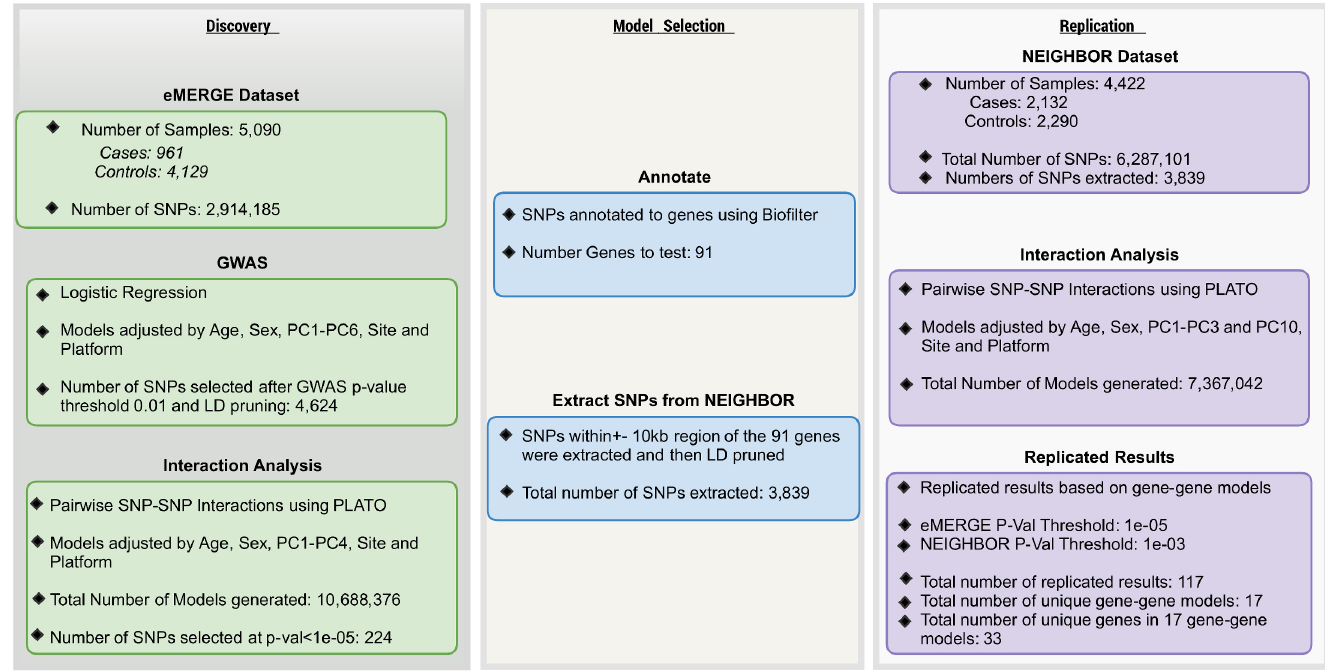
Fig 2. Flow chart explaining all the steps for gene based interaction analysis in discovery (eMERGE) and replication dataset